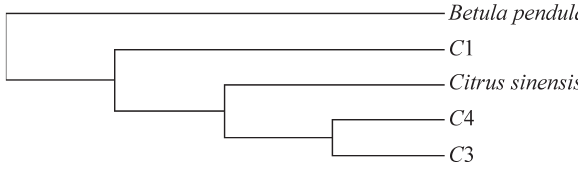
Figure 5 - Cladogram showing phylogeny relation among contigs 1, 3 and 4 with chalcone synthase from Citrus sinensis (BAA81664) and Betula pendula